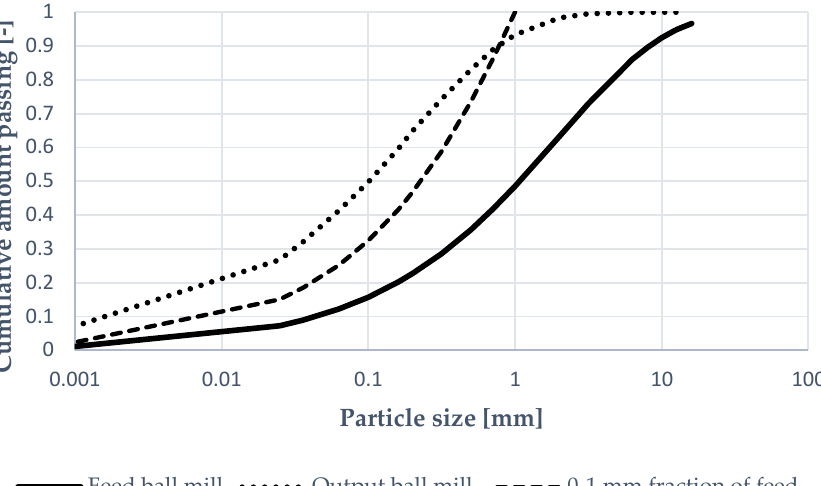
Figure 6. The size distribution of feed and product in the ball mill from MATLAB simulation re- sults.